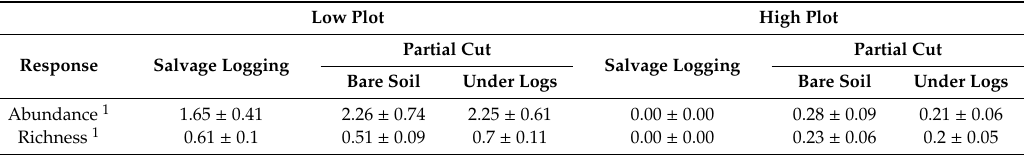
Table 3. Mean abundance (number of individuals / sample ± 1 SE of the mean) of macroarthropods (excluding ants) and richness of orders across burnt-wood treatments and